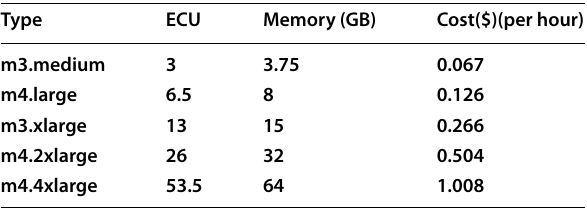
Table 1 VM types based on Amazon EC2 Type